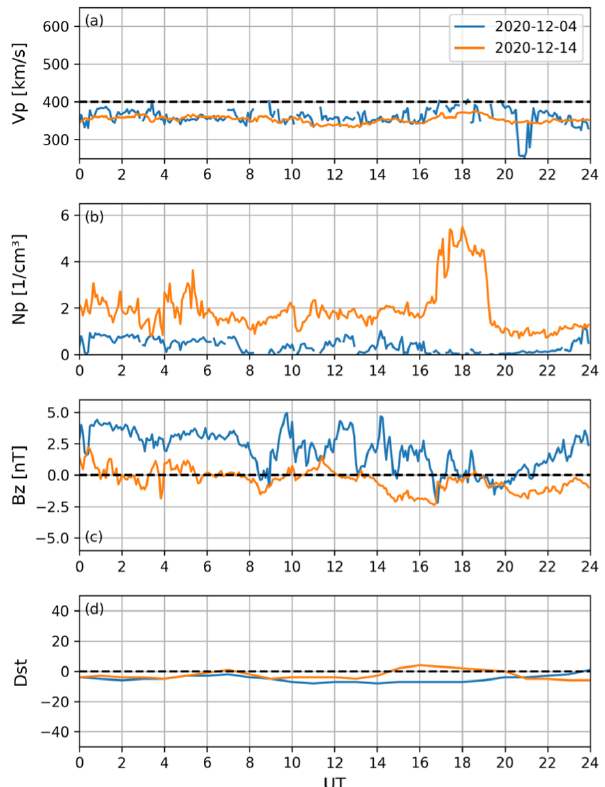
Figure 2. (a) The solar wind velocity V p , (b) the number density of protons N p , (c) the interplanetary magnetic field component B z , and (d) the Dst index on 14 December 2020 (orange line) and on 4 December 2020 (blue